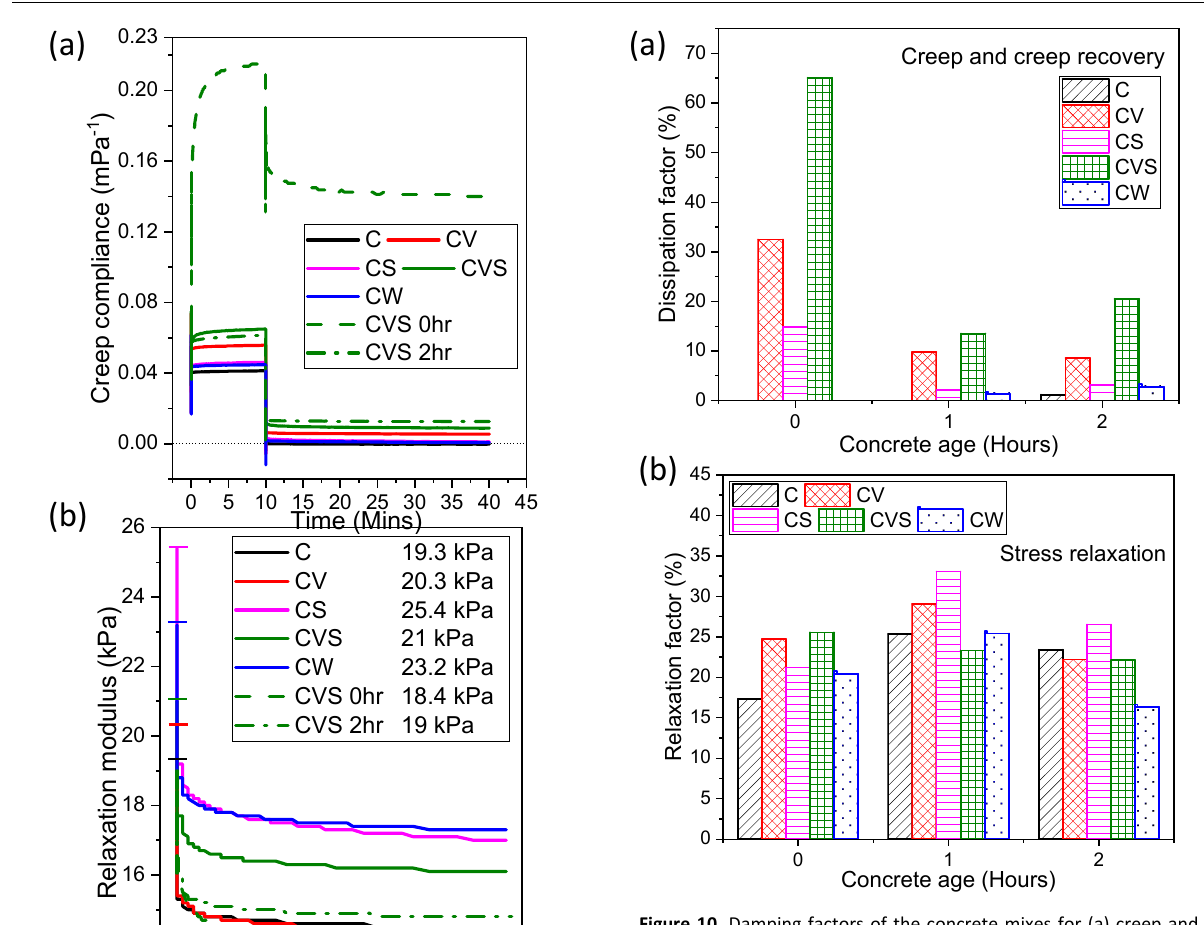
Figure 10. Damping factors of the concrete mixes for (a) creep and creep recovery (b) stress